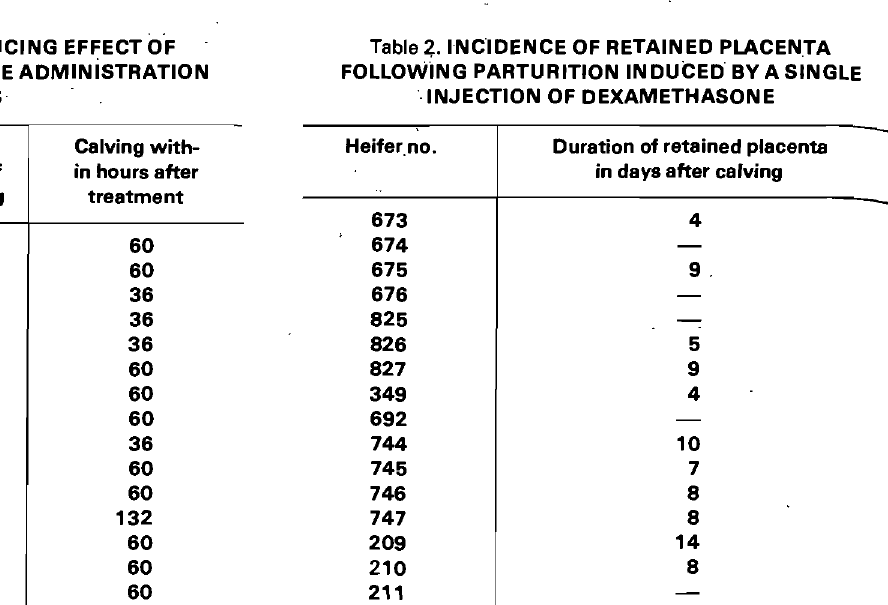
Table 1 . PARTURITION-INDUCING EFFECT OF Table~. INCIDENCE OF RETAINED PLACENTA FOLLOWING PARTURITION INDUCED BY A SINGLE ·INJECTION OF